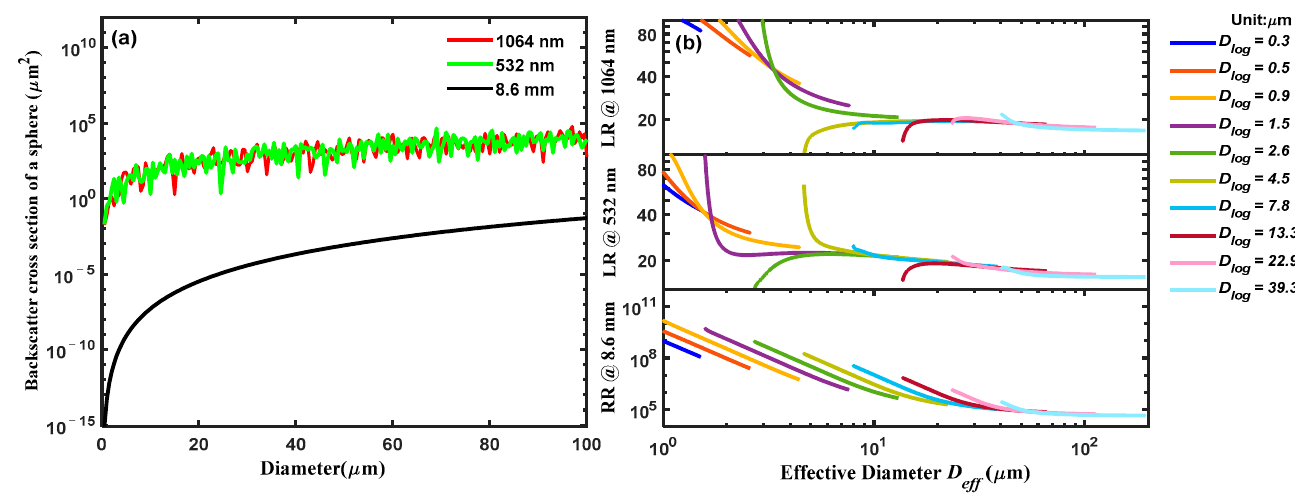
Figure 2. ( a ) The backscatter cross section of lidar at 532 nm (green) and 1064 nm (red), and radar at 8.6 mm (black); ( b ) The relations between lidar ratio ( LR λ ) and radar ratio ( RR ) with effective diameter.